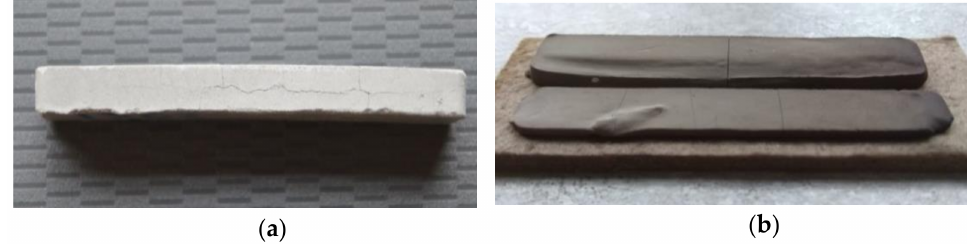
Figure 2. View of sample after solvent debinding in heptane ( a ) and after thermal debinding ( b